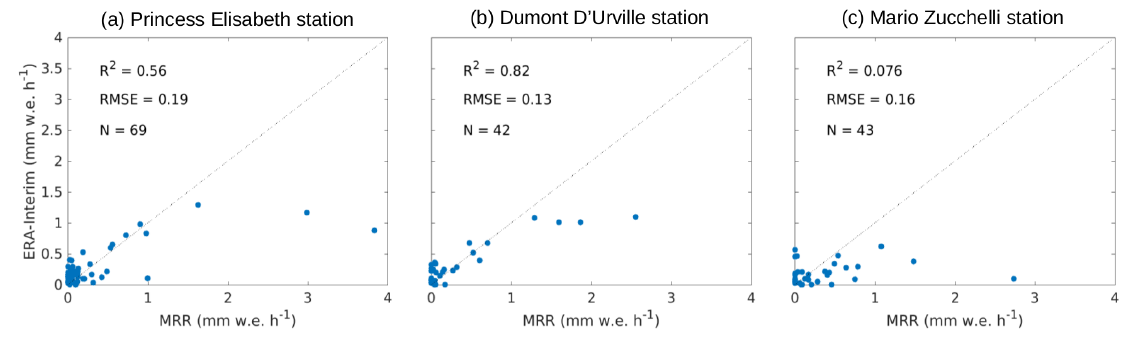
Figure 9. Daily snowfall amount comparison between ERA-Interim reanalysis and the MRR. R 2 denotes the adjusted coefficient of deter- mination, RMSE is the root mean square error, N indicates the number of observations and the thin line is the